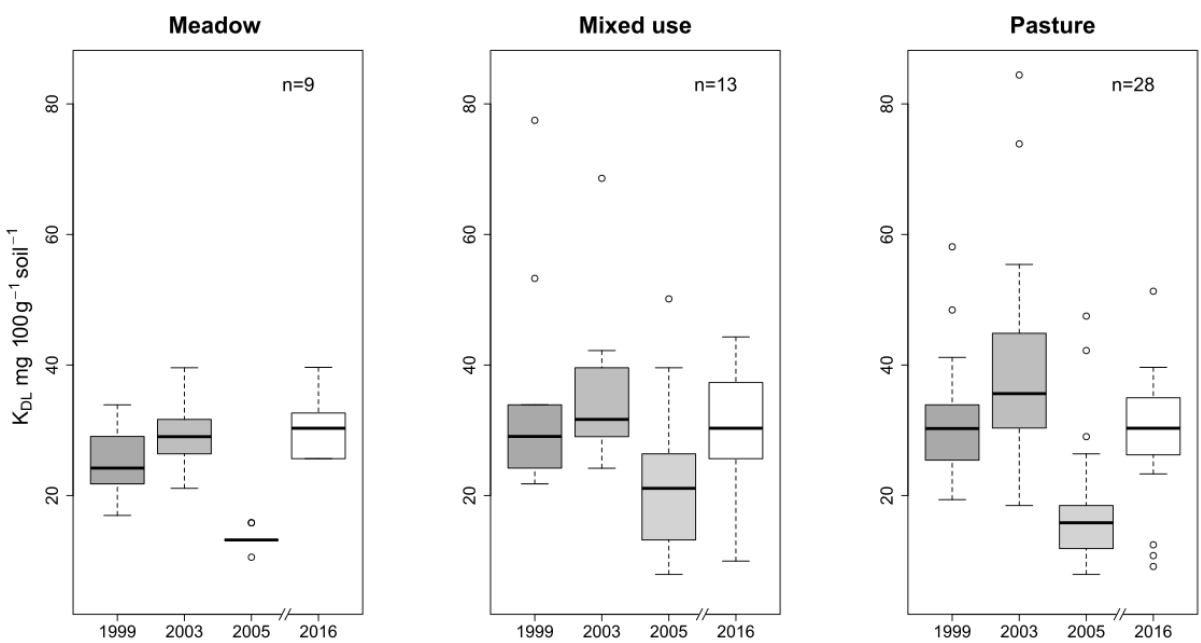
Figure 4. Dynamics of K DL content (0–10 cm) for the three types of grassland management (box plots are marked by the first and third quartile, the median divides the box, the whiskers represent observations outside the 9–91 percentile range, and values falling outside the range are dot-plotted as